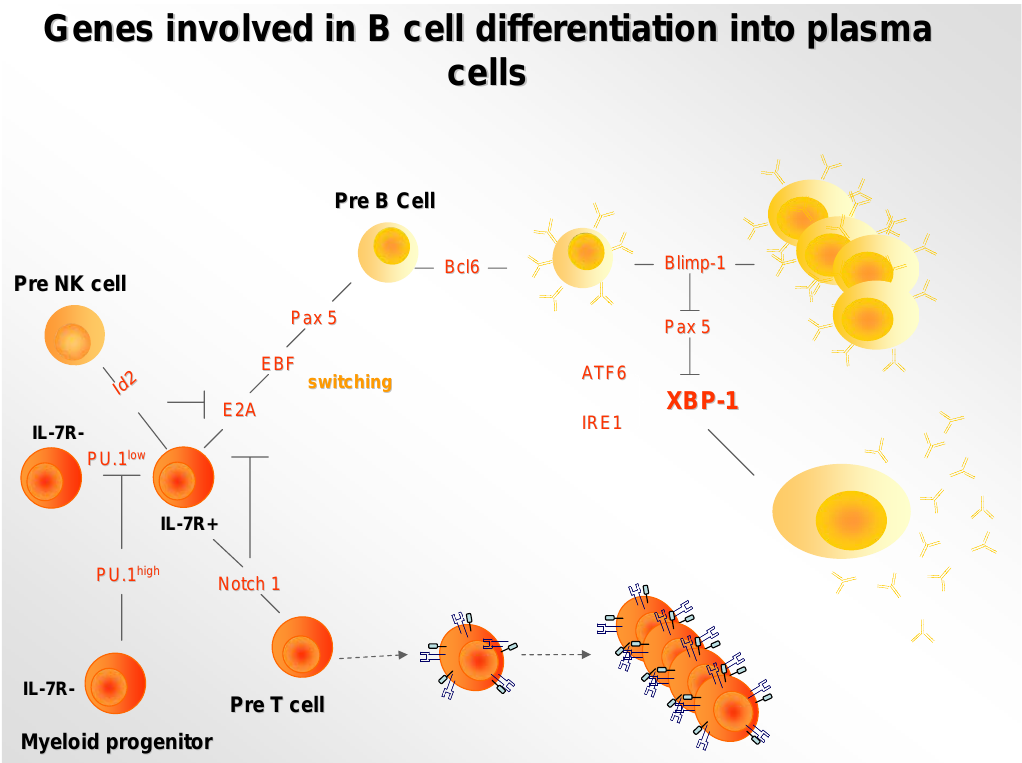
Fig. 1B – Genes expressed in the maturation of B cells from the myeloid precursor to plasma cells. All genes that must be expressed at each step of T cell differentiation are denoted. The sequential expression of these genes is necessary and the order in which they are expressed is represented from left to right in the figure. IL-7R represents the surface expression of the interleukin-7 receptor.